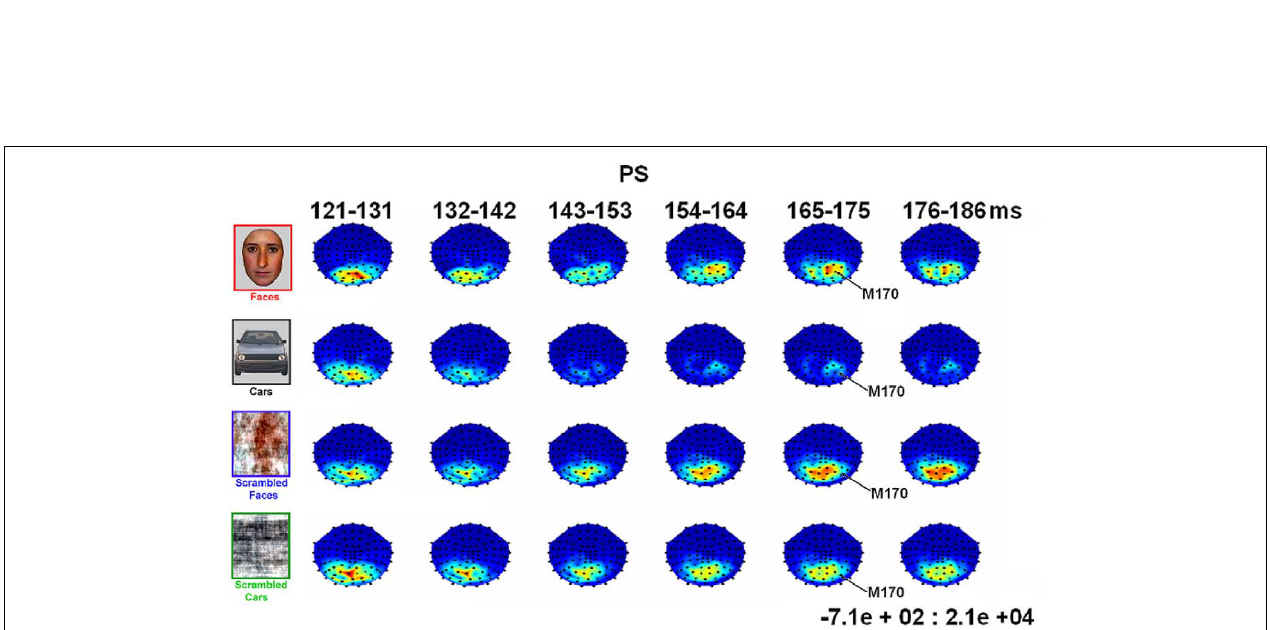
component in Experiment 1 (viewed from above, nasion upward; data are interpolated linearly between sensors, indicated by black dots, after their spherical projection onto a 2D surface). Red indicates increased signal magnitude (RMS) relative to pre-stimulus baseline (in units of